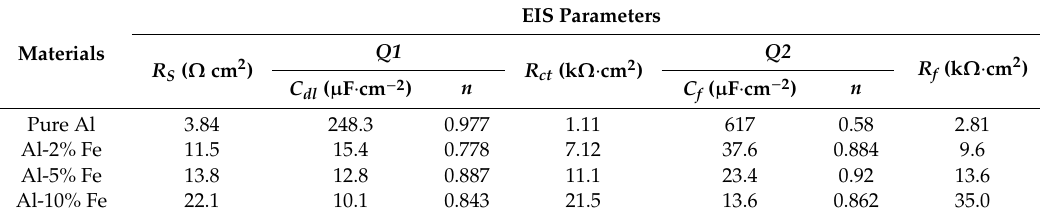
Table 3. Electrochemical-impedance-spectroscopy (EIS) parameters for pure Al and Al-Fe alloys after one hour of immersion in 3.5% NaCl solution.